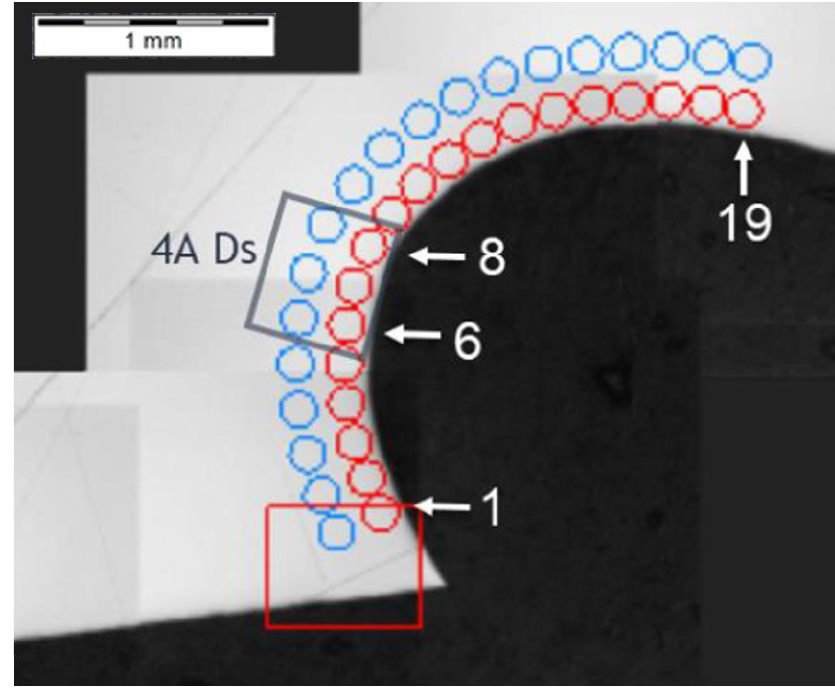
Figure 25. Pattern of hardness verification. Paths depth (distance from tooth surface): 0.1 mm and 0.3 mm. Cross-section I-I, zone: 4A Ds.